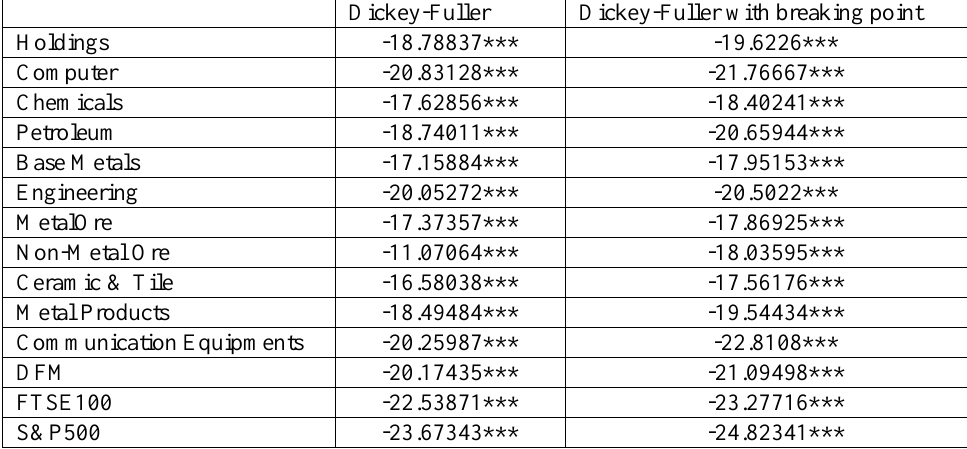
Table 4-1.Unit Root Test